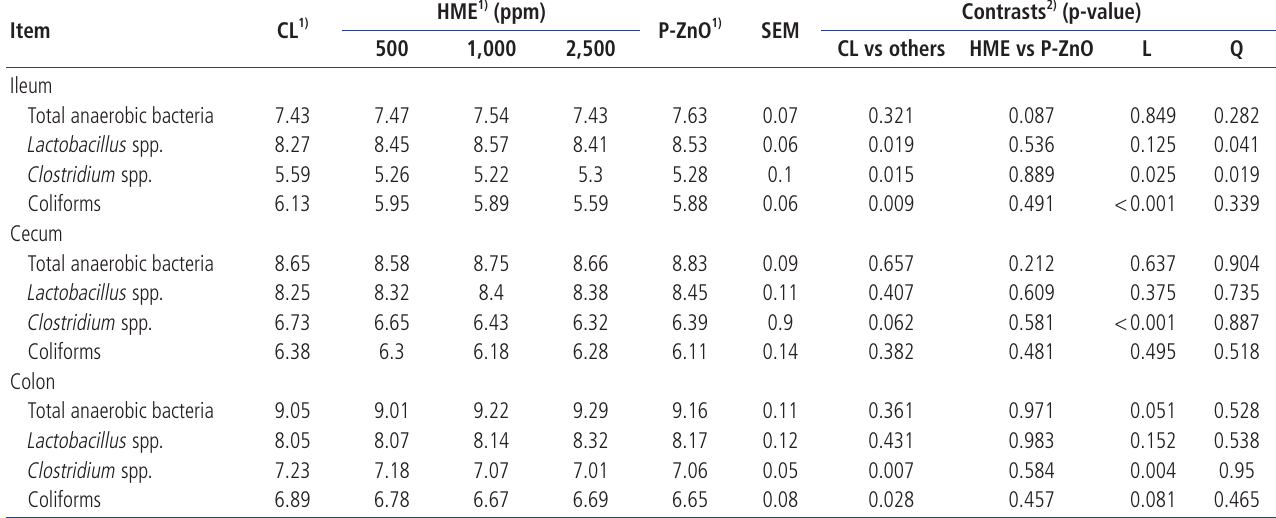
Table 6. Effects of different ZnO sources on intestinal microbial populations (Log10 CFU/g) in weanling pigs (d 28)